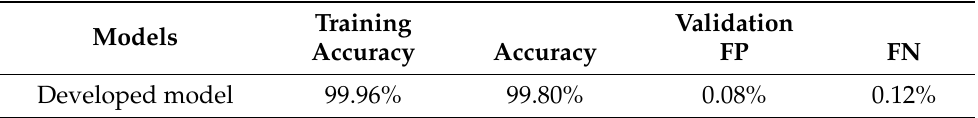
Table 3. Accuracy and false rates of reconstructing profiles by the developed framework (Type-I dataset).